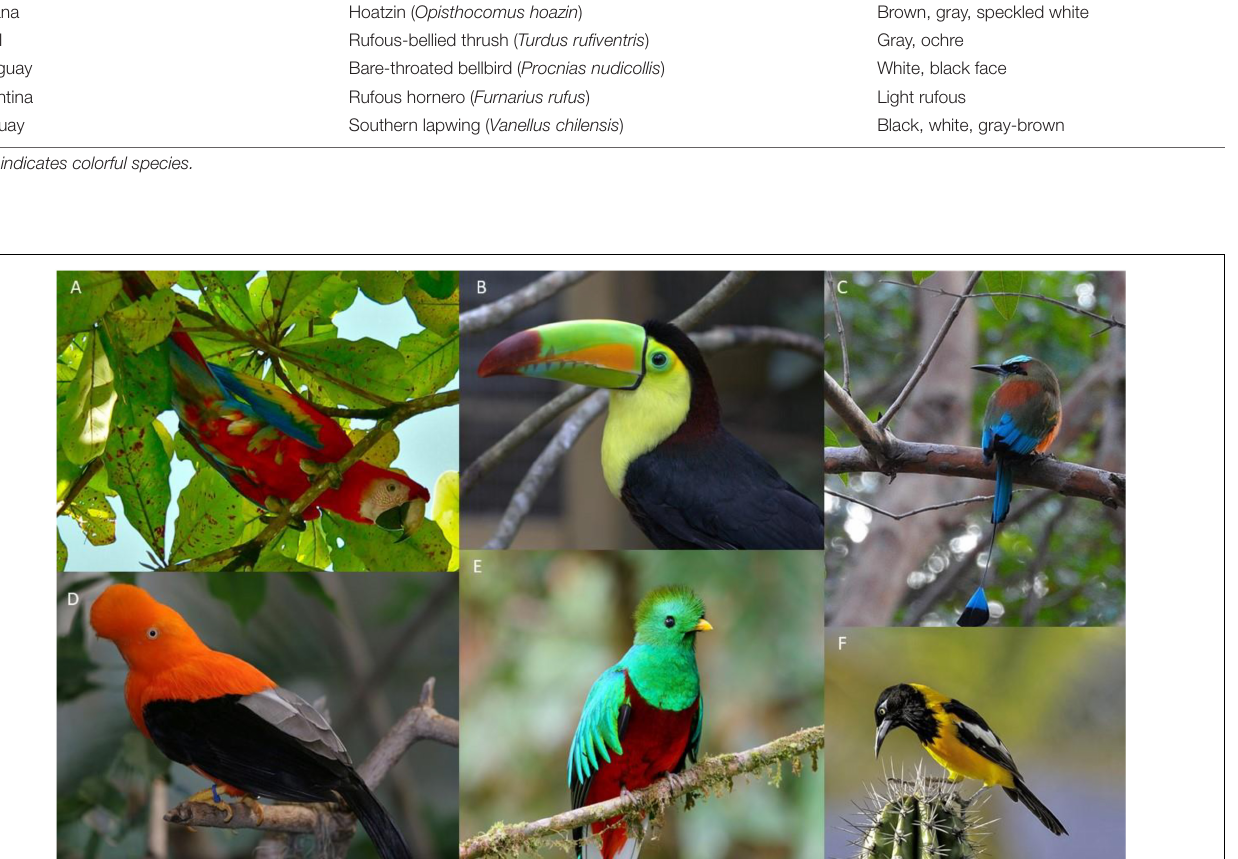
Frontiers in Ecology and Evolution |